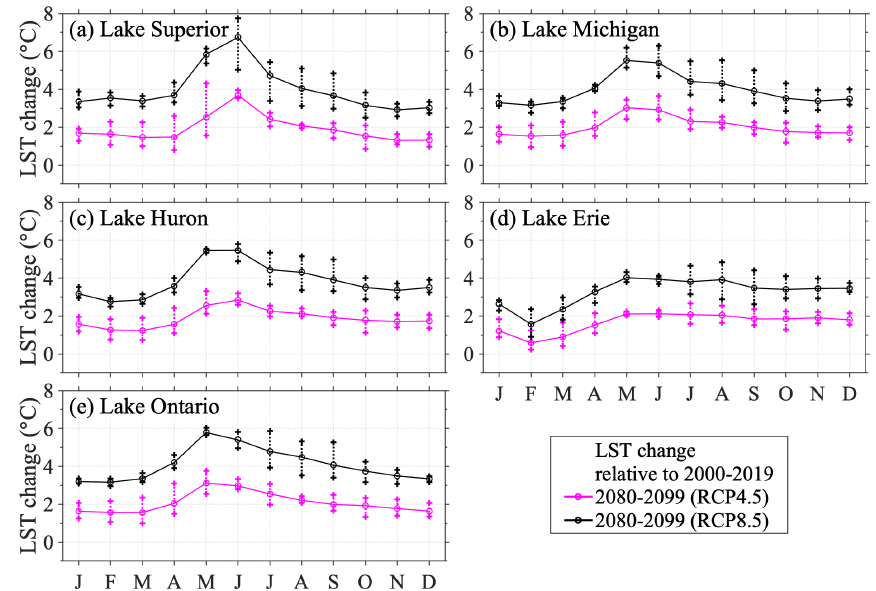
Figure 10. Projected changes in monthly LST in the five lakes in the late century (2080–2099) for the RCP 4.5 and RCP 8.5 scenarios, relative to the present-day climate (2000–2019). Vertical error bars indicate the range of the three individual GLARM projections for RCP4.5 (pink) and RCP 8.5 (black).